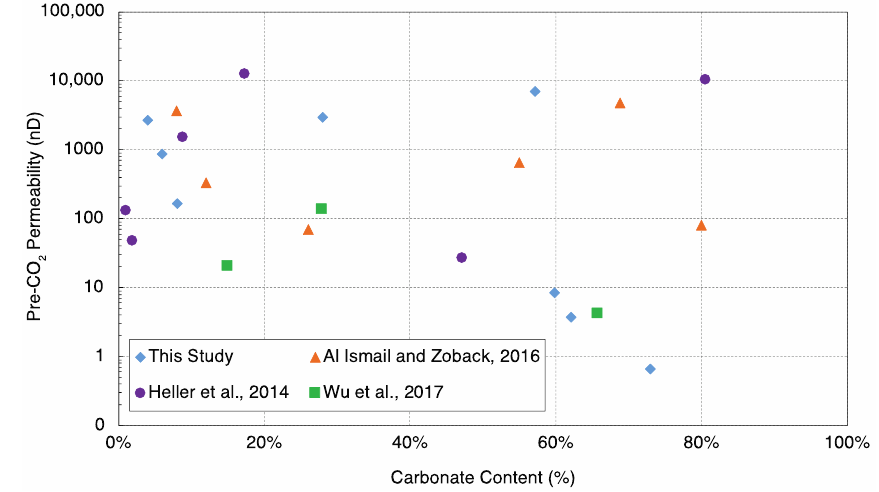
Figure 12. Carbonate content vs. pre-scCO 2 permeability.